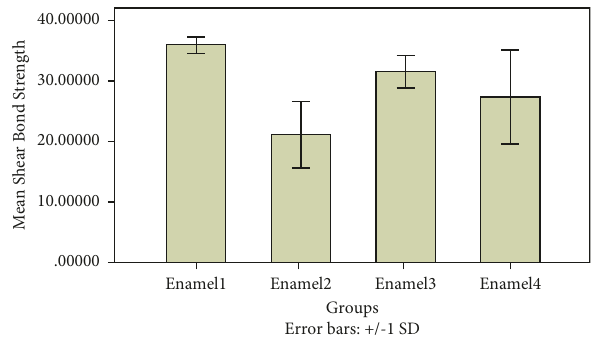
Figure 2: Comparison of mean shear bond strengths of enamel groups subjected to different bonding